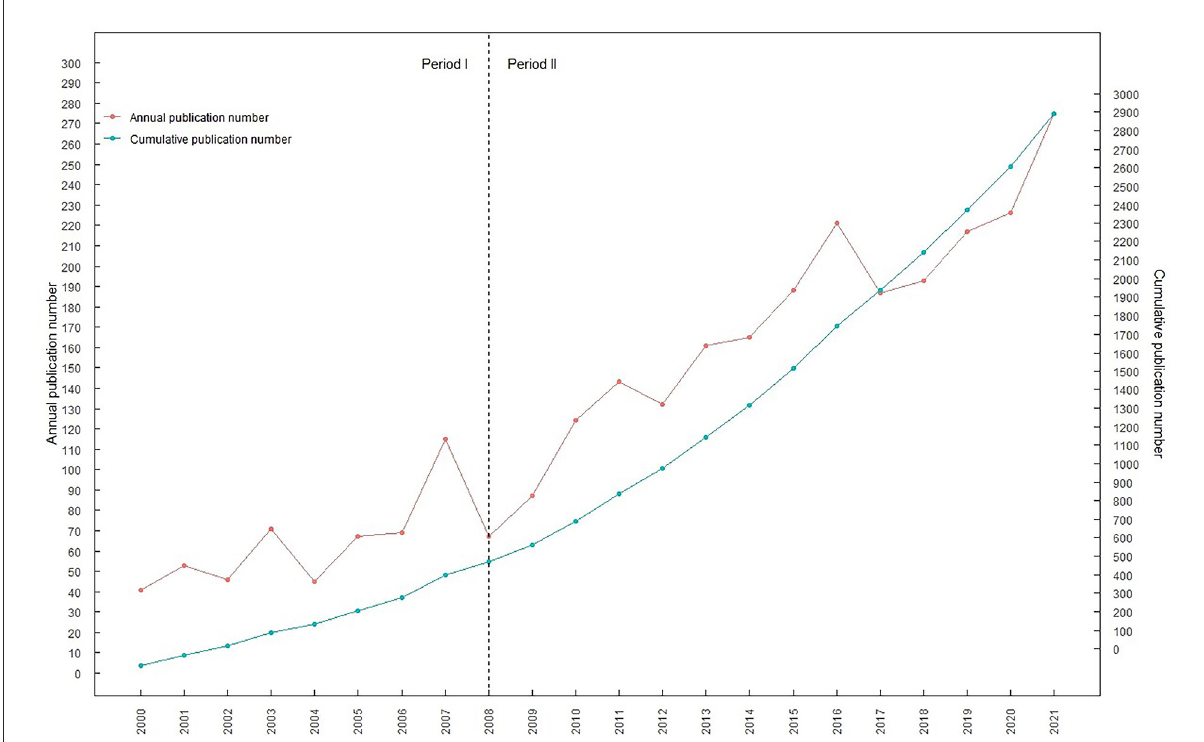
FIGURE2 Publications of publications in tinnitus treatment research from 2000 to 2021. The red curve represents the annual publication number and the blue curve represents the cumulative publication